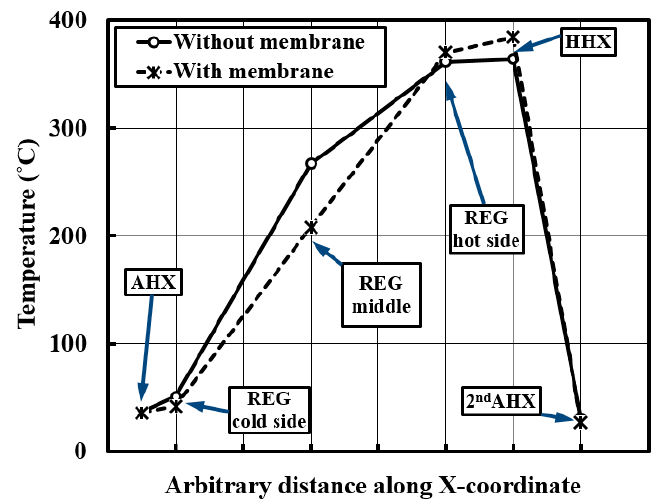
Figure 12. The effect of the presence of a concave membrane on the temperature profiles in the thermoacoustic core.